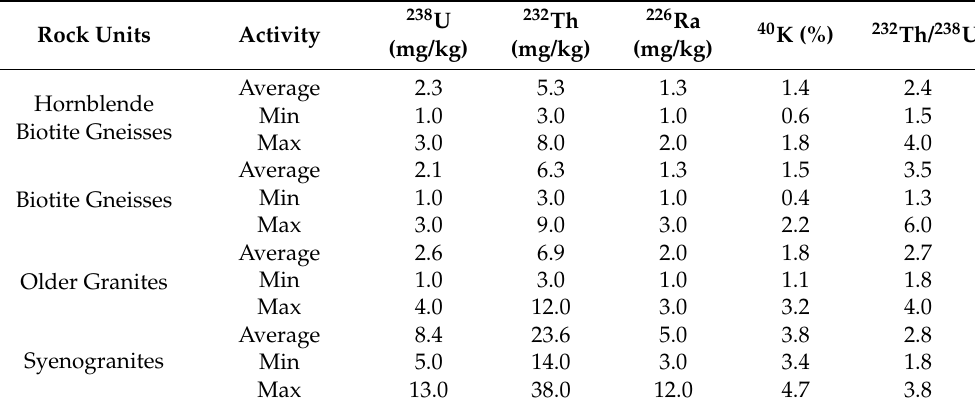
Table 1. Average, minimum (Min), and maximum (Max) radiometric measurements of the studied rocks in the study